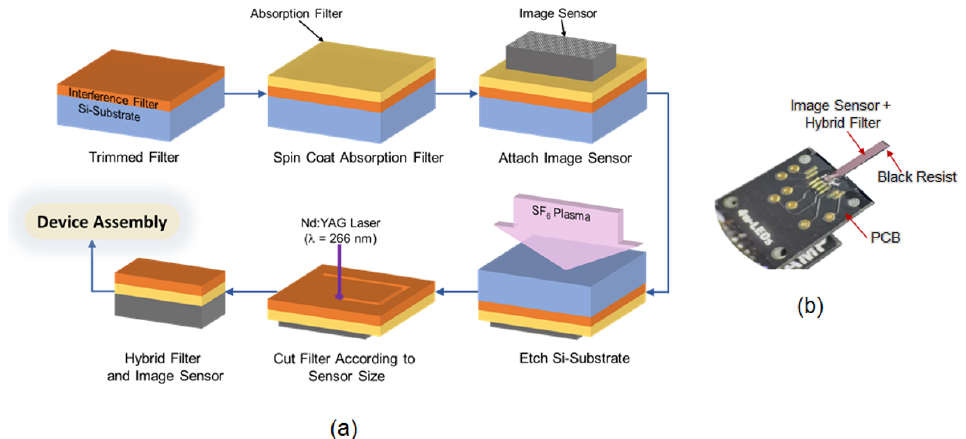
Figure 2. ( a ) Schematic of the hybrid filter fabrication using the plasma etching technique. ( b ) Photograph of the image sensor assembled with the designated printed circuit